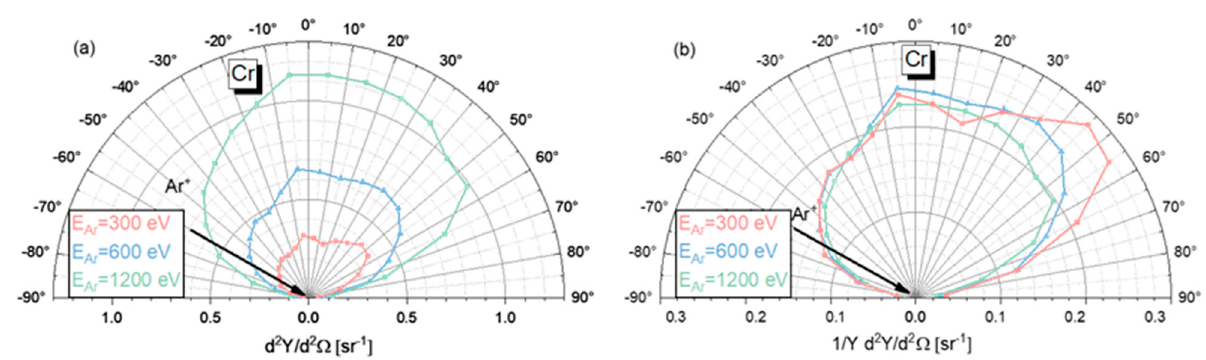
Figure 9. ( a ) Angular distribution of Cr atoms sputtered by Ar ions at 60° ion incidence for different ion energies. ( b ) Angular distribution normalized with the total sputtering yield.